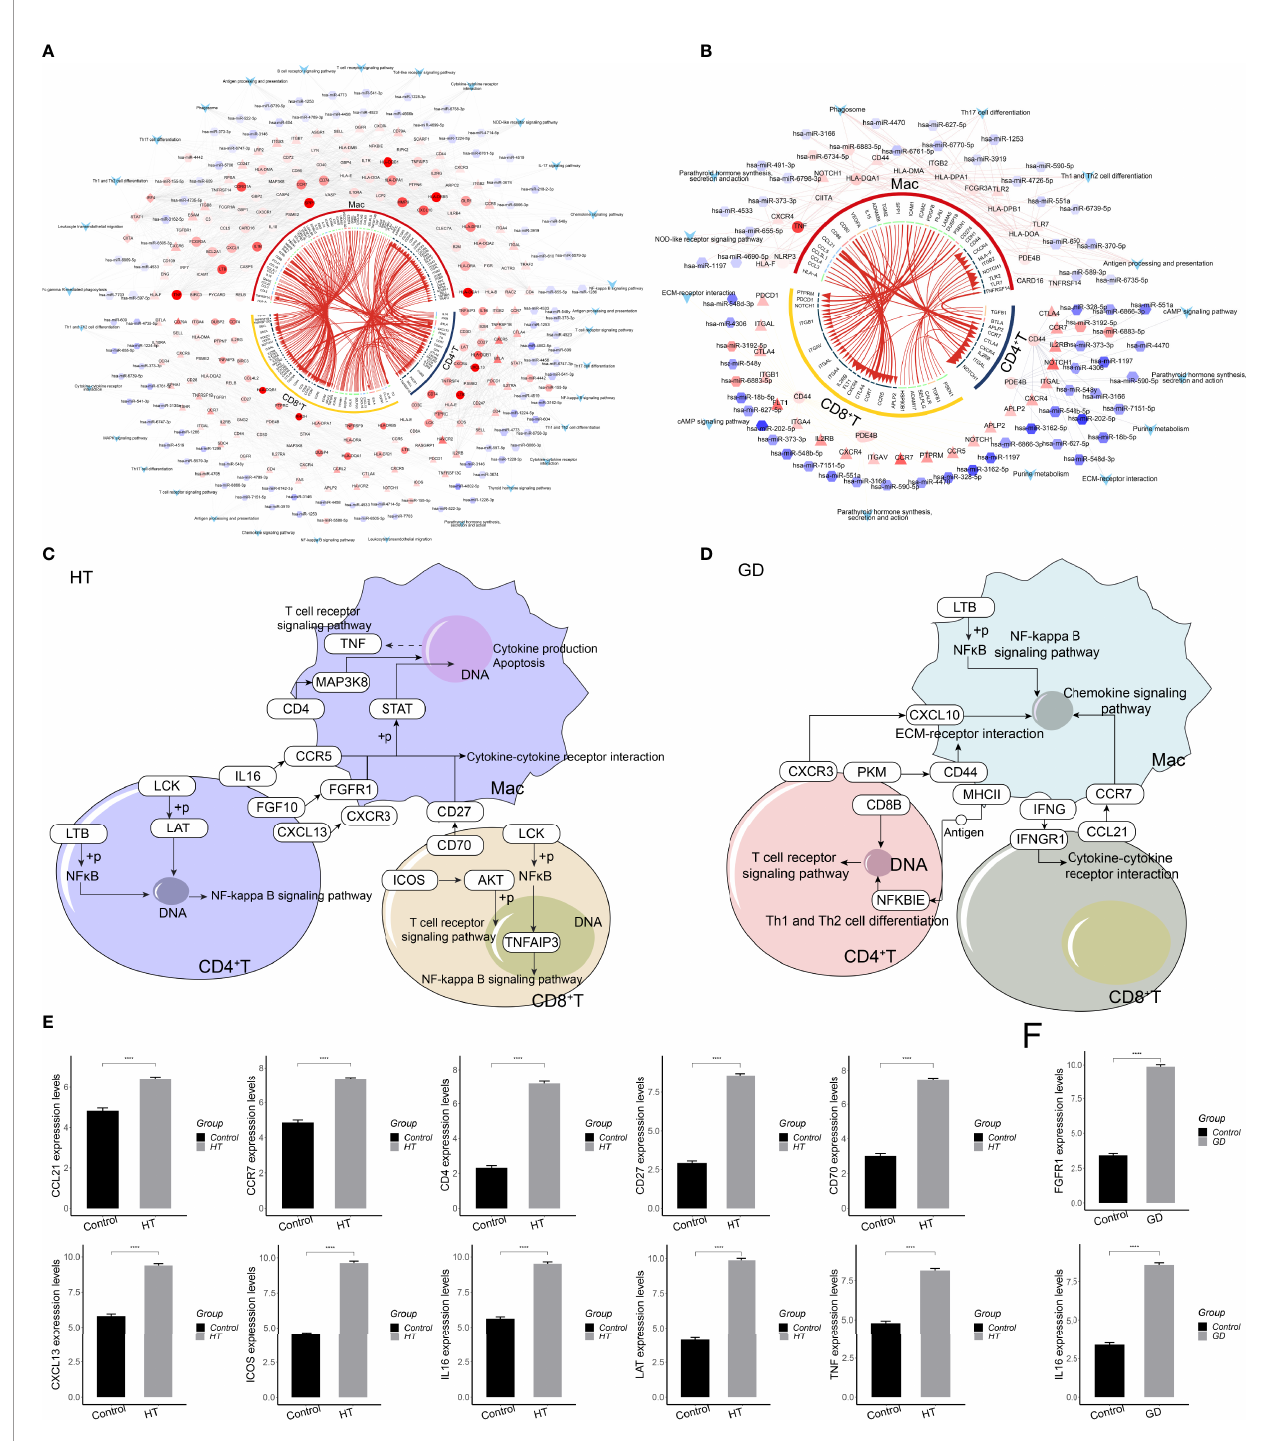
FIGURE 7 | Global regulatory network of microenvironmental T cells and macrophages in HT and GD. (A, B) Global regulatory network of communication between microenvironmental T cells and macrophages in HT (A) and GD (B) patients. Circles represent ligand genes, triangles represent receptor genes, hexagons represent miRNAs, diamonds represent TFs, and V shapes represent signaling pathways. (C, D) In HT (C) and GD (D) patients, the global dysregulation mechanism of microenvironmental T cells and macrophages. (E, F) qPCR of genes involved in HT (E) and GD (F) regulatory networks. GD, Graves ’ disease; HT, Hashimoto ’ s thyroiditis. ****P <